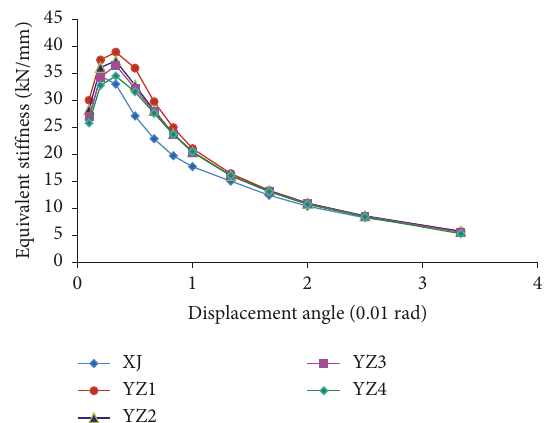
Figure 10: Stiffness degradation